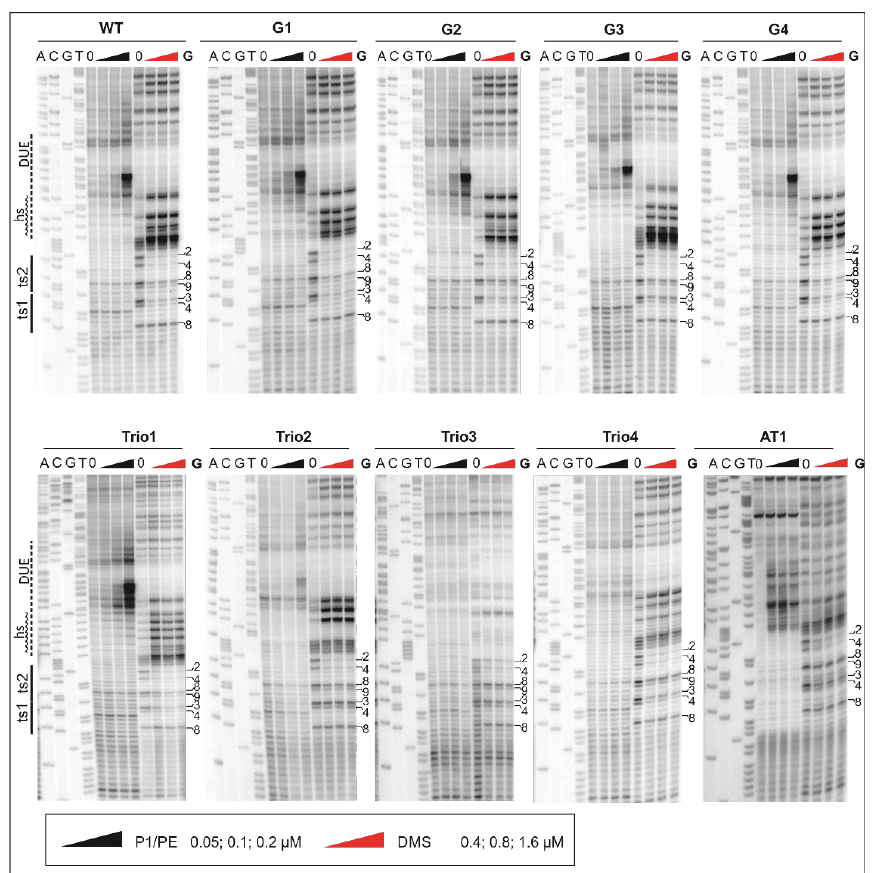
Figure 3. Analysis of DnaA binding to the 5′ DUE border and DUE-proximal boxes. After incubation with the indicated amounts of DnaA, plasmid were treated with P1 nuclease or DMS and used as templates in PE reactions. The DUE and ts boxes are marked to the left of the gels; DMS-modified guanine (G) residues in ts1 and ts2 DnaA boxes are labeled to the right of the gels. In the poriWT P1/PE analysis, PE products were detected starting from the 3rd resi- due downstream of DnaA box ts2, and they extended along approximately 24 nt in the 3 ′ direction from DnaA box ts2, indicating the presence of the 22-nt ssDNA (Figure 4).